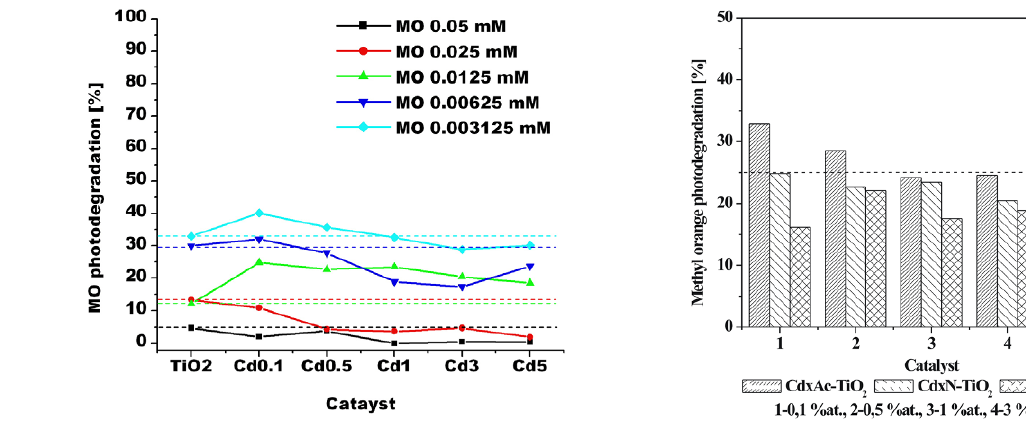
Figure 3. Photocatalytic degradation of Methyl orange after 6 h of irradiation.